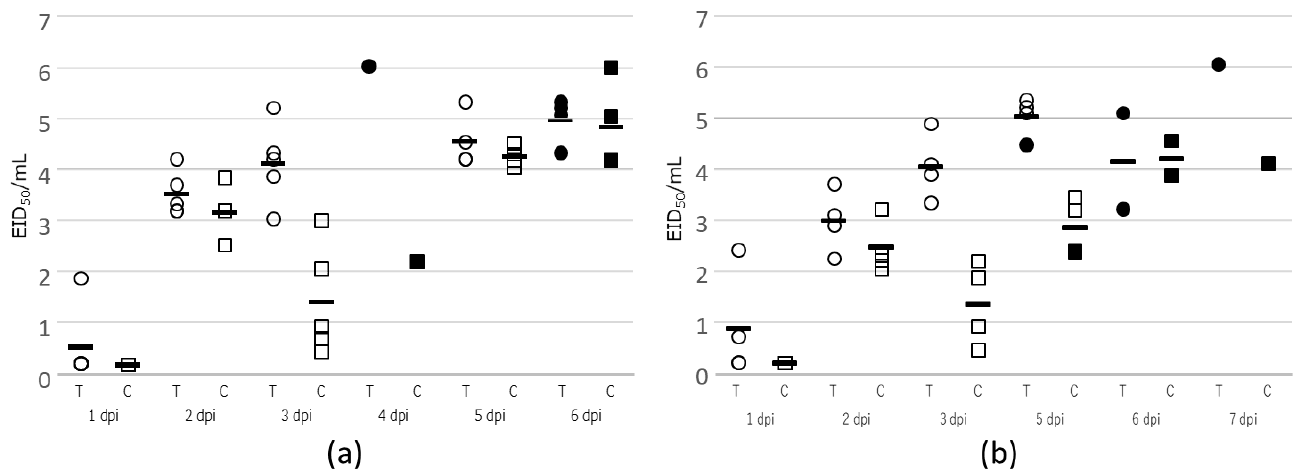
Figure 2. Kinetics of viral titer in tracheal (T) and cloacal (C) swabs collected from infected chickens. ( a ) 10 6 EID 50 inoculation group. ( b ) 10 5 EID 50 inoculation group. Circle, viral titer in tracheal swab; square, viral titer in cloacal swab; bar, the mean of viral titer; black circles and squares, viral titer in tracheal and cloacal swab, respectively, at time of death. The detection limit of viral titer was 10 0.2 EID 50/mL .